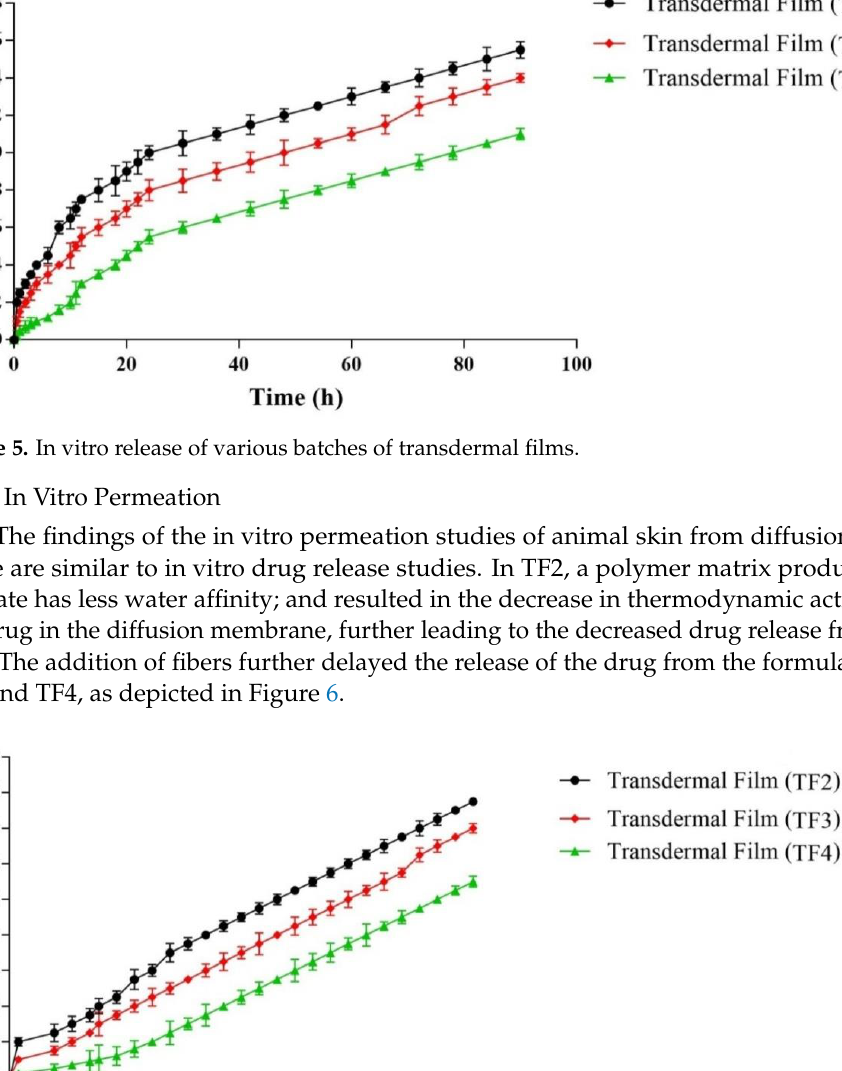
Table 5. In vitro drug release (kinetic modeling) data of various transdermal film batches.